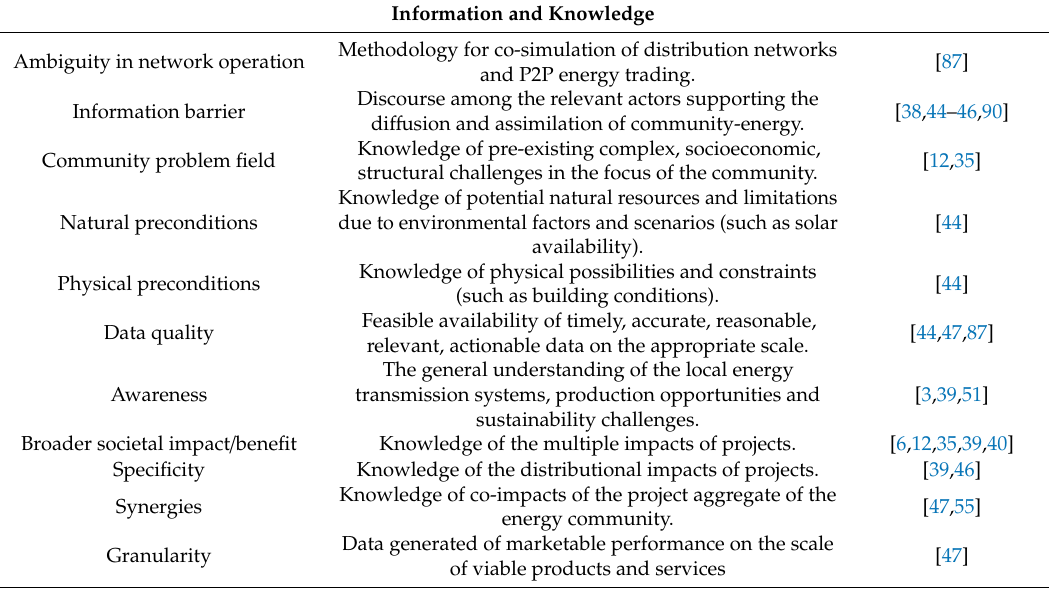
Table 3. Information and knowledge related progression